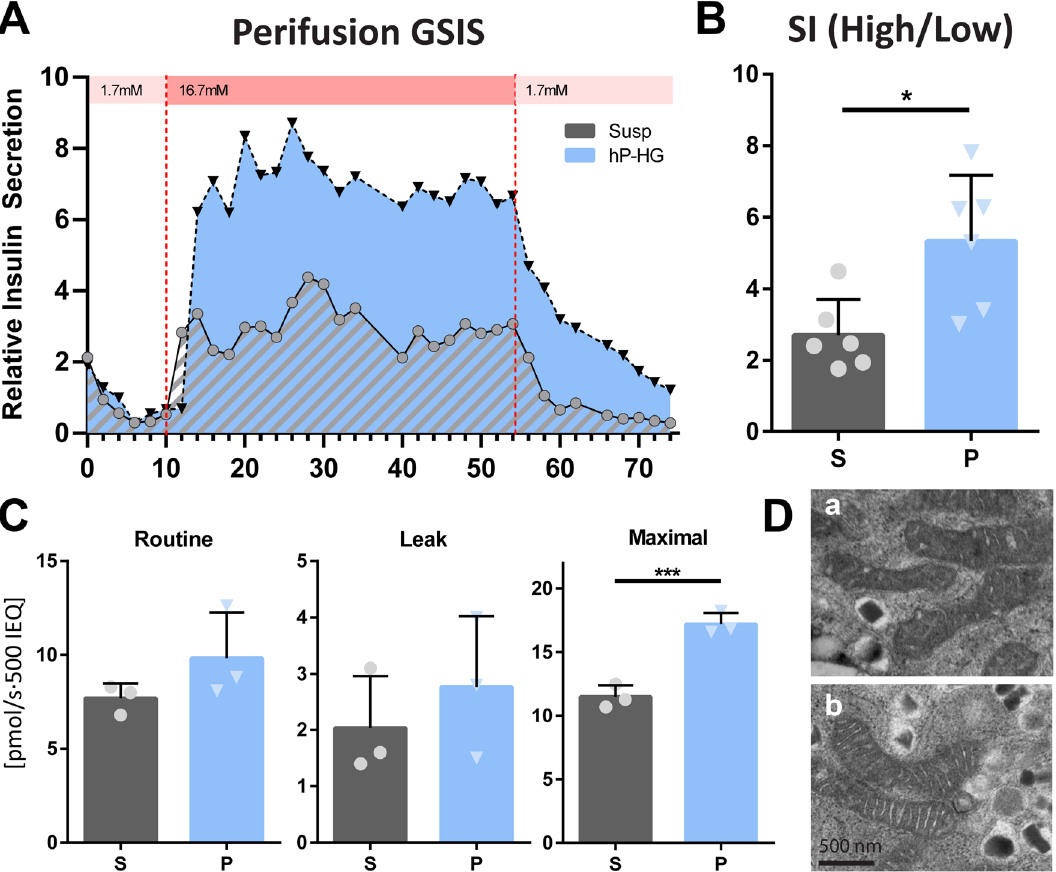
Figure 4. hP-HG culture enables proper dynamic function and enhances maximum respiration. (A) Perifusion GSIS was performed on human islets after 2 days of culture in either suspension (S) or embedded in hP-HG (P), from low glucose (1.7 mM) to high glucose (16.7 mM) and back to low glucose; representative plots shown were generated from 2 technical replicates per treatment, from one islet donor. Insulin secretion is normalized to first low glucose response (unitless). One representative donor is shown, data from additional donors can be found in Supplemental Fig. 4D,E. (B) Average stimulation index (SI, high/low glucose) is reported, N = 3 islet donors. (C) Islets were assessed for mitochondrial respiration after 2 days of culture in either suspension (S) or hP-HG (P); Routine (normal media), Leak (Complex V inhibition), and Maximal (uncoupled) respiration were measured. (D) β cell mitochondrial pathology in suspension (a) and hP-HG (b) culture was assessed with transmission electron microscopy. N = 3 islet donors. Scale = 500 nm. ( ns not significant, *p < 0.05, ***p <